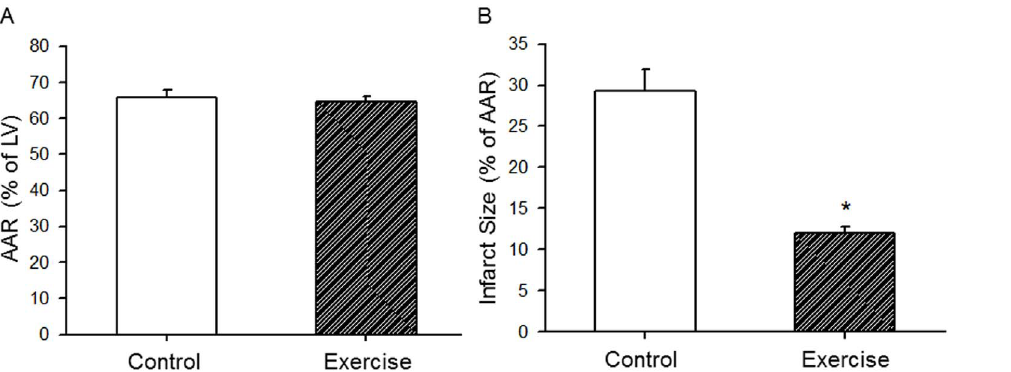
Figure 7. The effect of endurance exercise training on myocardial I/R injury. Following 8 weeks of endurance exercise, mice were subjected to LAD occlusion followed by 24 h reperfusion. Area at risk (AAR) and infarct size were measured with Evans blue and TTC staining. A, there was no significant